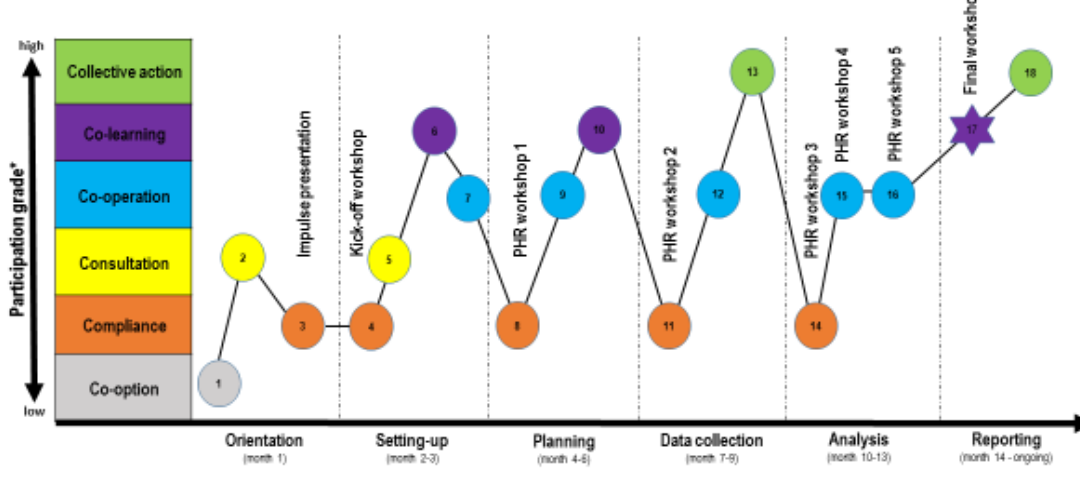
Figure 1. Co-researchers’ participation during PHR project, presented per phase in the project and per level of participation [43]. Legend: 1—literature review; 2—field visit, 3—impulse presentation;